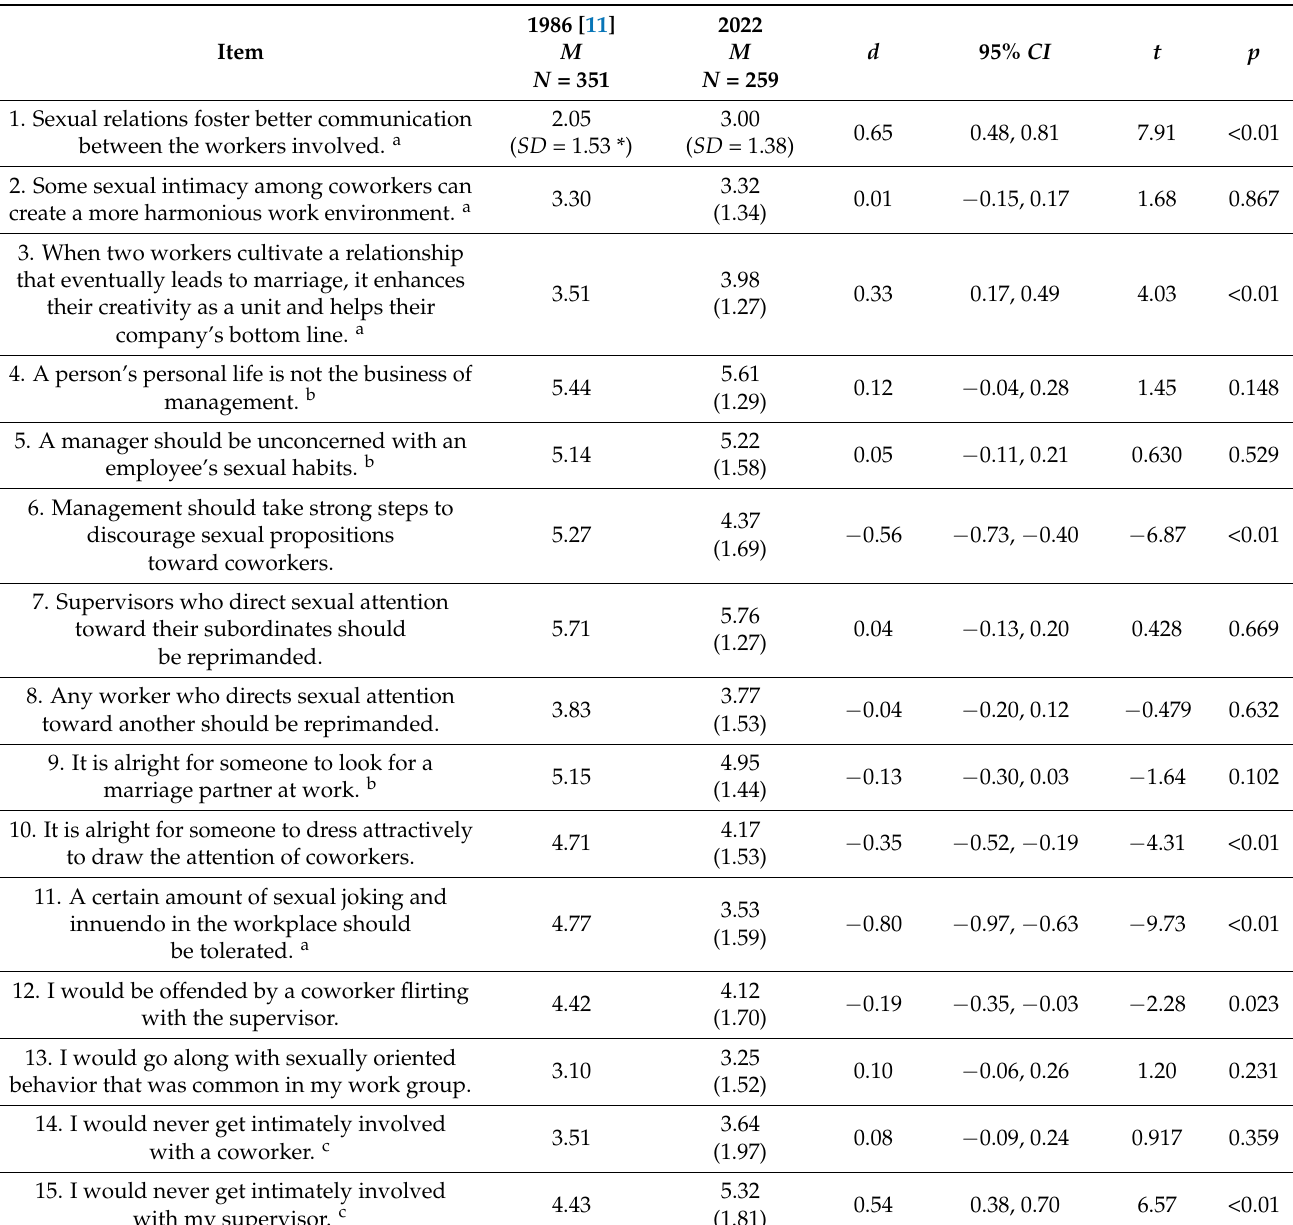
Table 1. Workplace romance